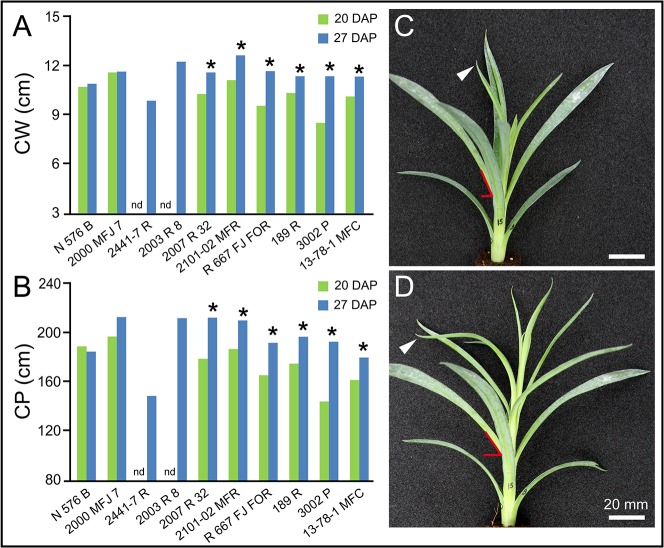
Stem cutting morphology of carnation cultivars.Average stem cutting (A) width and (B) perimeter values are shown for the studied cultivars. Asterisks indicate significant differences (P < 0.05) over time for a given cultivar. Nd: not determined. (C-D) A representative stem cutting imaged (C) 20 and (D) 27 DAP. White arrowhead points to the same leaf. Red lines are drawn to highlight leaf angles. Images were obtained as described in Materials and Methods.